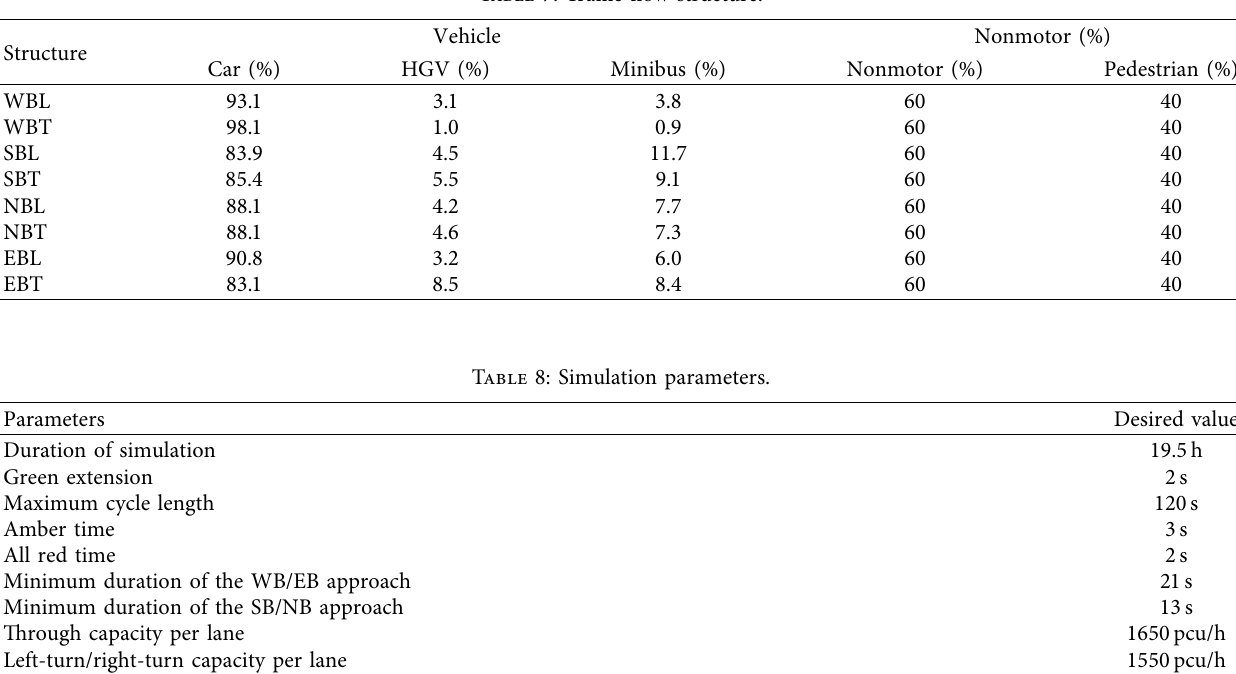
In this table, WBL means westbound left, WBT means westbound through, and so Table 7: Traffic flow structure.